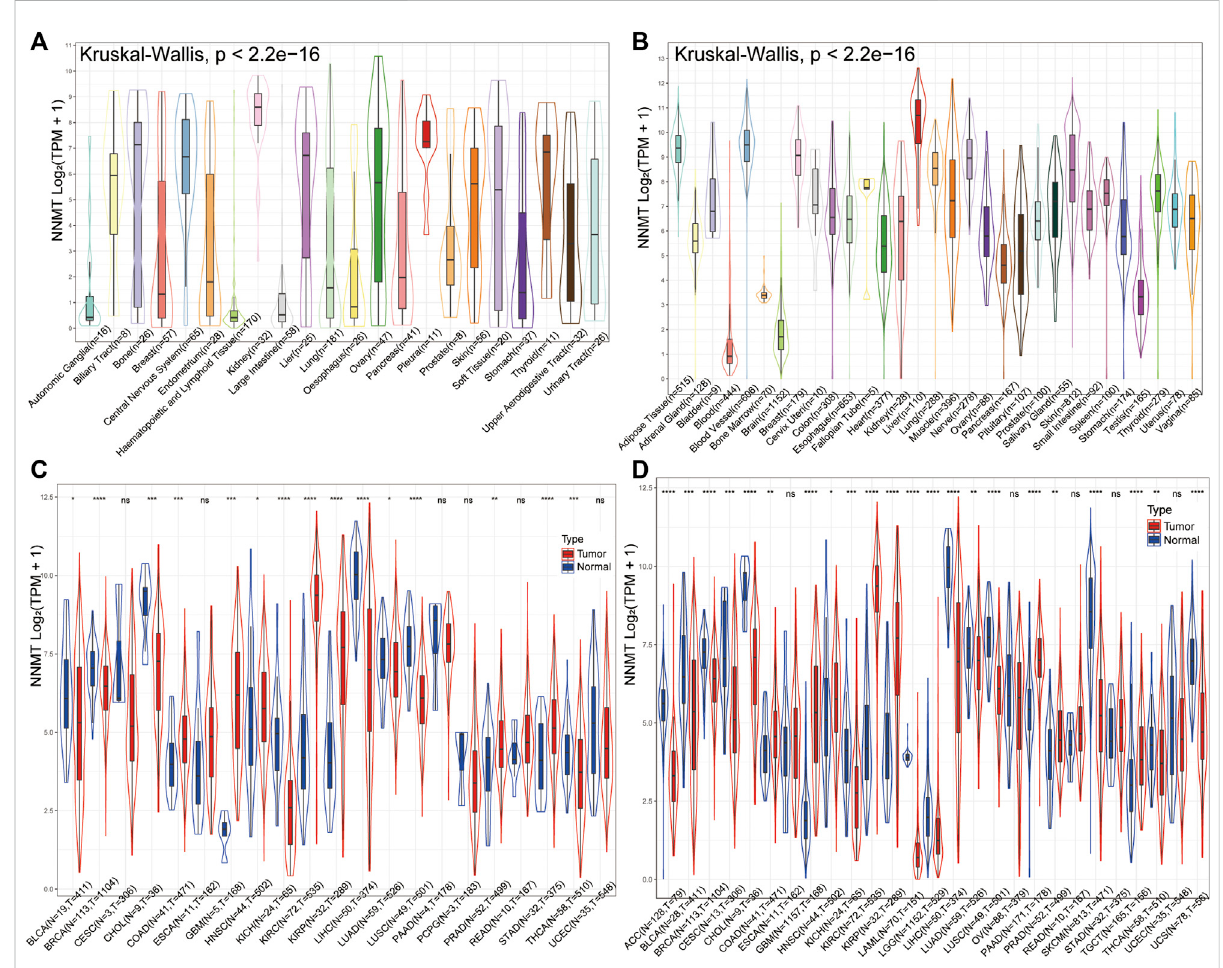
FIGURE 2 DifferentialexpressionofNNMT. (A) NNMTexpressioninmultiplenormalorgansfromGTExdatabase; (B) NNMTexpressionlevelsincancercell lines from CCLE database; (C) NNMT expression differences between tumor and normal samples for 21cancers from TCGA data alone; (D) NNMT expression differences between tumor and normal sample combined TCGA and GTEx for 27 cancers. ( “ ns ” means “ no signi fi cance ” , * p < 0.05, ** p